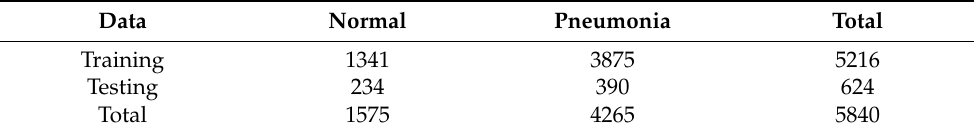
Table 6. Metrics for the compared networks on the Chest-2 dataset.